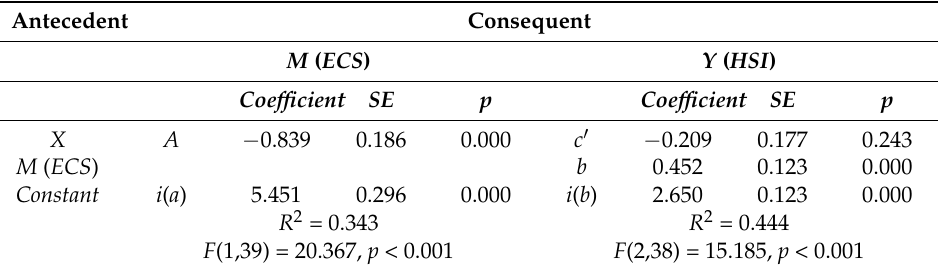
Table 5. Coefficients for the effect of active creation on well-being ( HSI ).